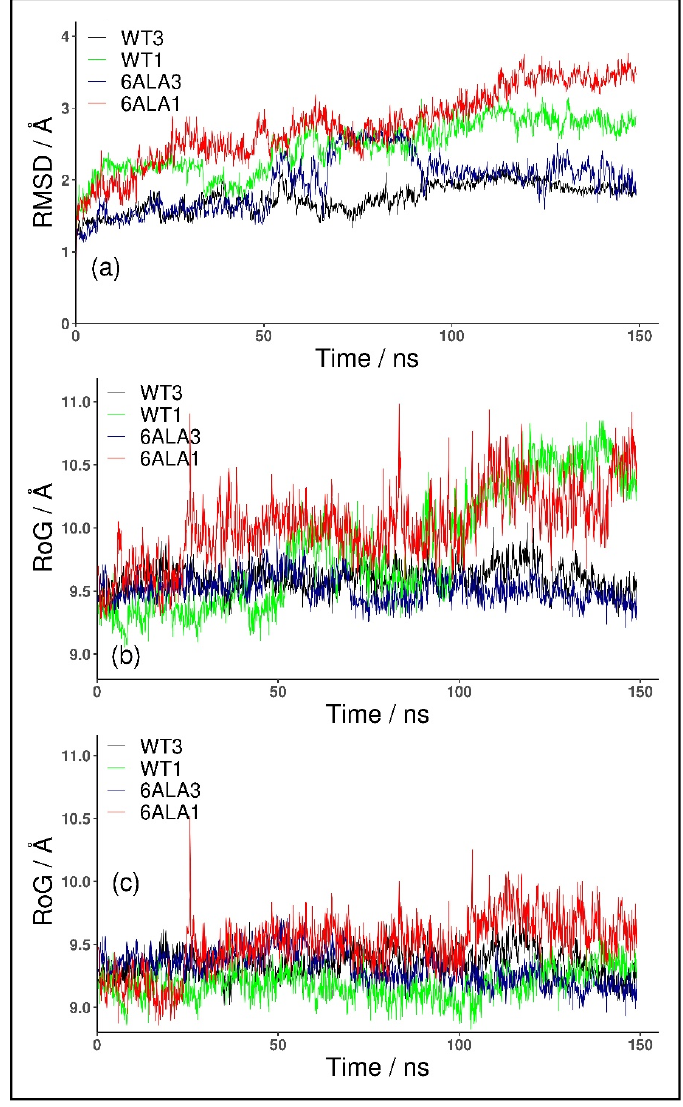
Figure 2. RMSD and RoG for the trajectory obtained for the trimeric biologically active enzyme, WT3 PNP (black); the monomeric form, WT1 PNP (green), derived in silico from the X-ray structure of the trimer; 6Ala3 trimeric (blue) and 6Ala1 monomeric (red) forms of the 6Ala mutant of PNP (obtained in silico). RMSD of C α all atoms, calculated with respect to the starting structure ( a ) and RoG of the active site amino acids with ( b ) and without ( c ) the His64 residue included in the RoG calculation are